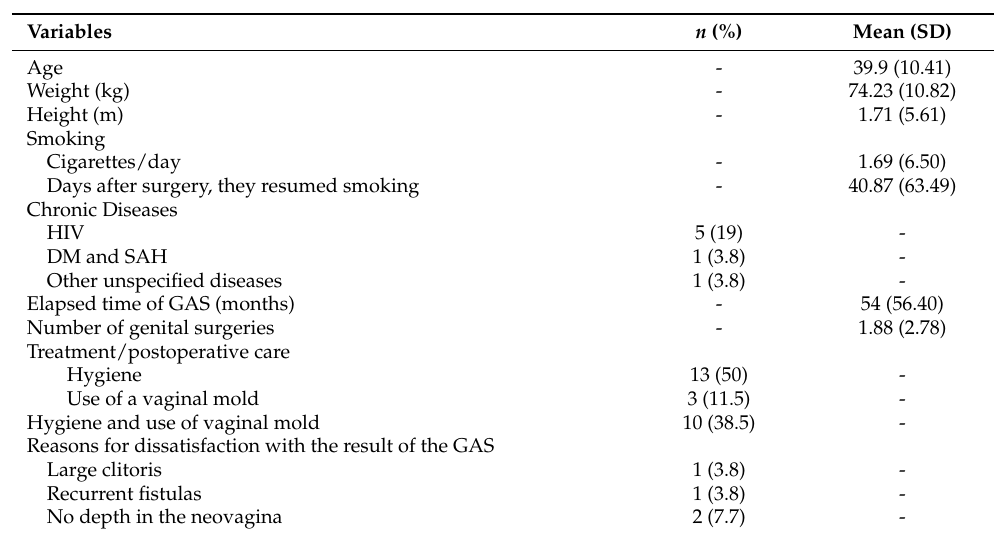
Figure 1. Flow chart of patient enrollment. HCPA: Hospital de Clinicas de Porto Alegre; GAS: Gender-Affirming Surgery.